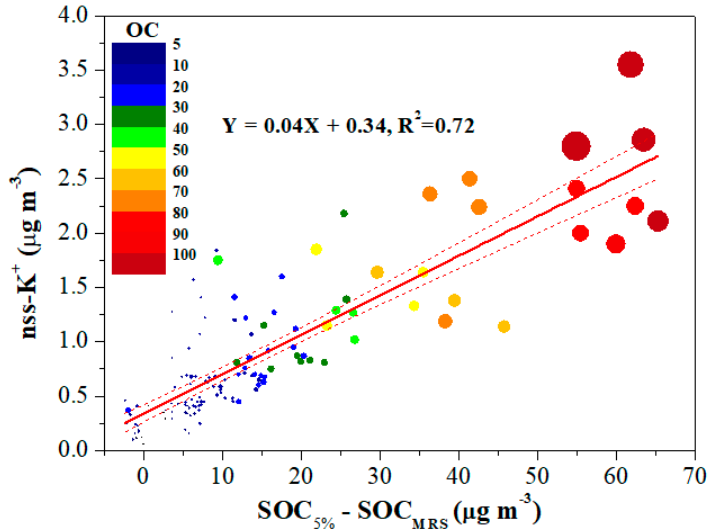
Figure 6. Correlation between the differences in SOC concentrations deriving from the 5% percentile and MRS methods with nss-K + as a function of the OC concentration (colored scale) in Ioannina. The slight negative differences correspond to non-winter samples.